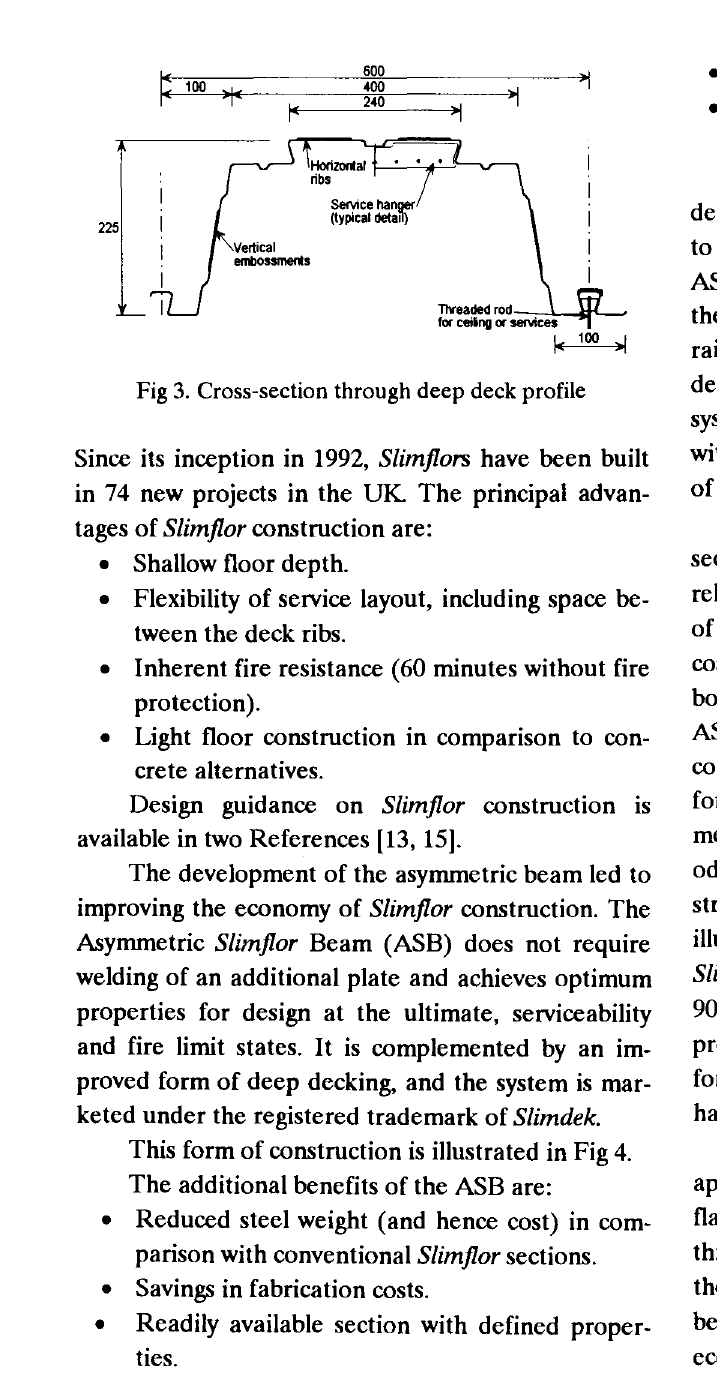
Fig 3. Cross-section through deep deck profile